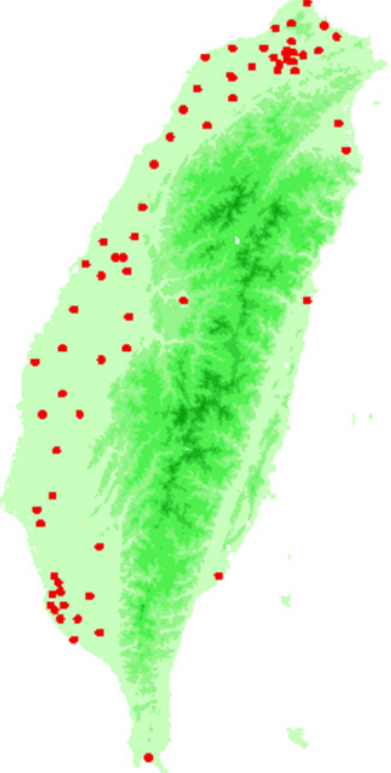
Fig. 1. The island of Taiwan with the locations of 74 air quality monitoring stations. The light and dark green indicate the coastal plain and mountain